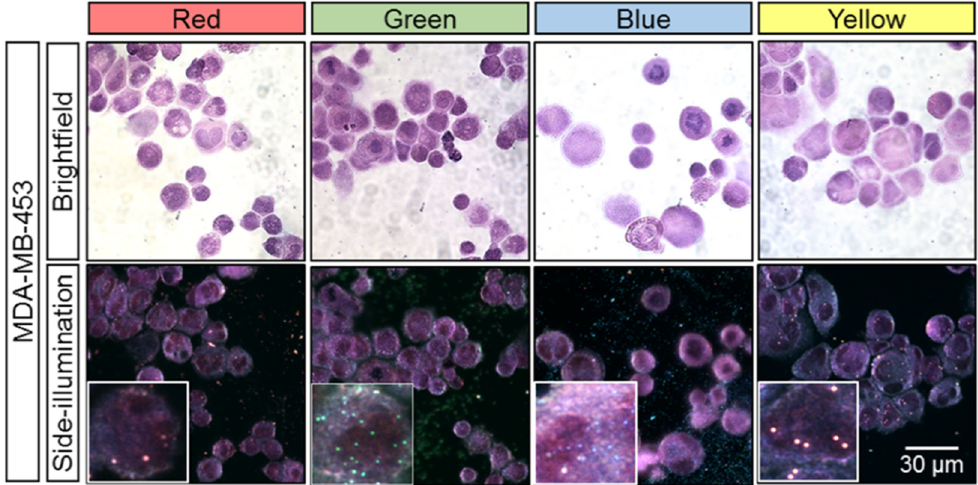
Figure 5. Adherent MDA-MB-453 cells stained with H&E (Gill II hematoxylin and eosin B) and ob- served with either bright-field or dark-field microscopy by using the SI microscopy adaptor for visualizing red, green, blue, and yellow plasmonic NPs. Insets: 15 × 15 µm.